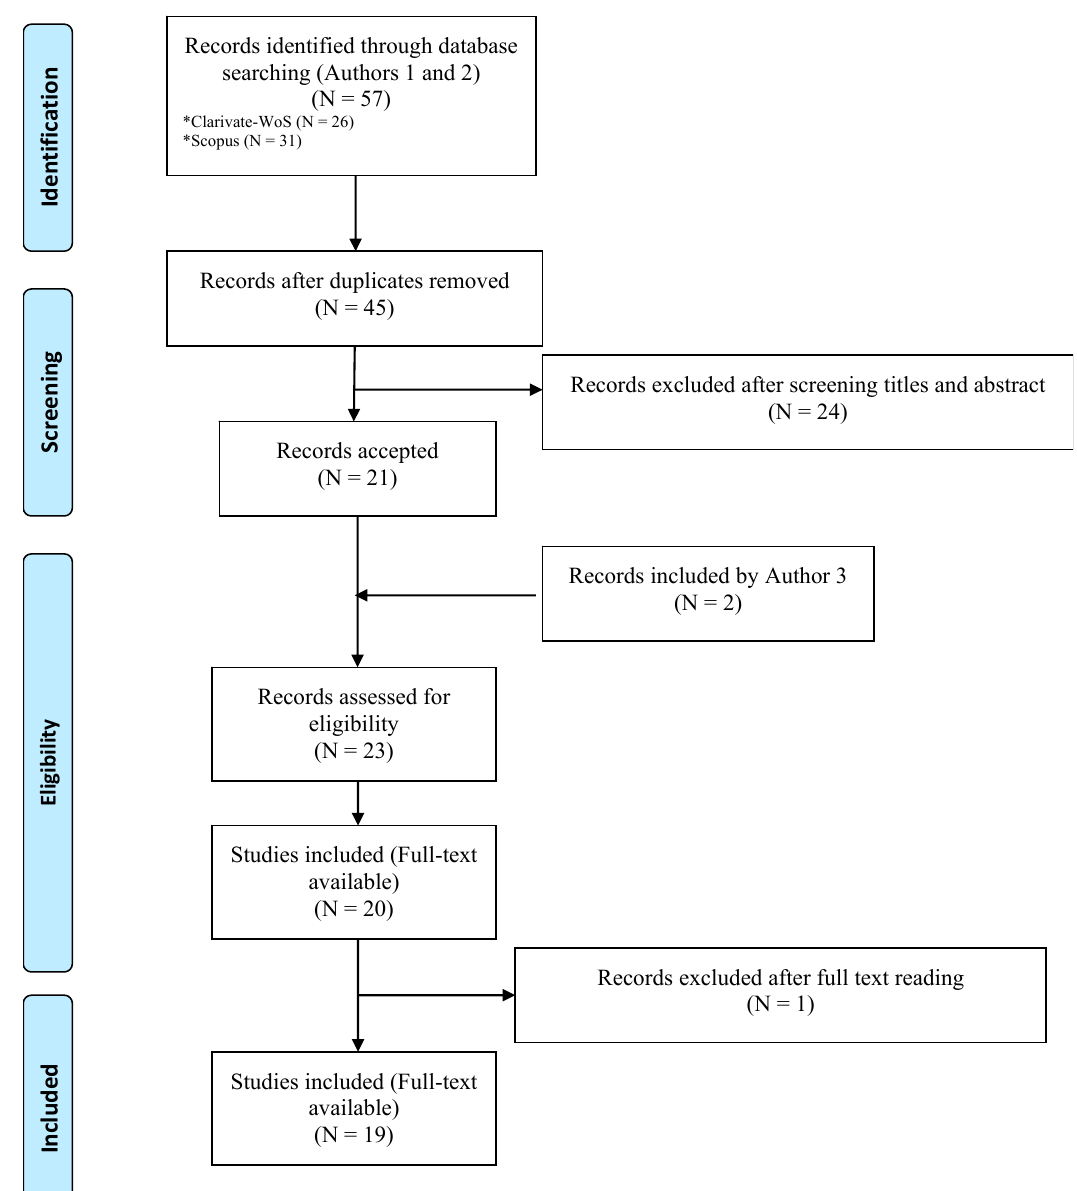
Figure 1. Flow chart of the study selection protocol.